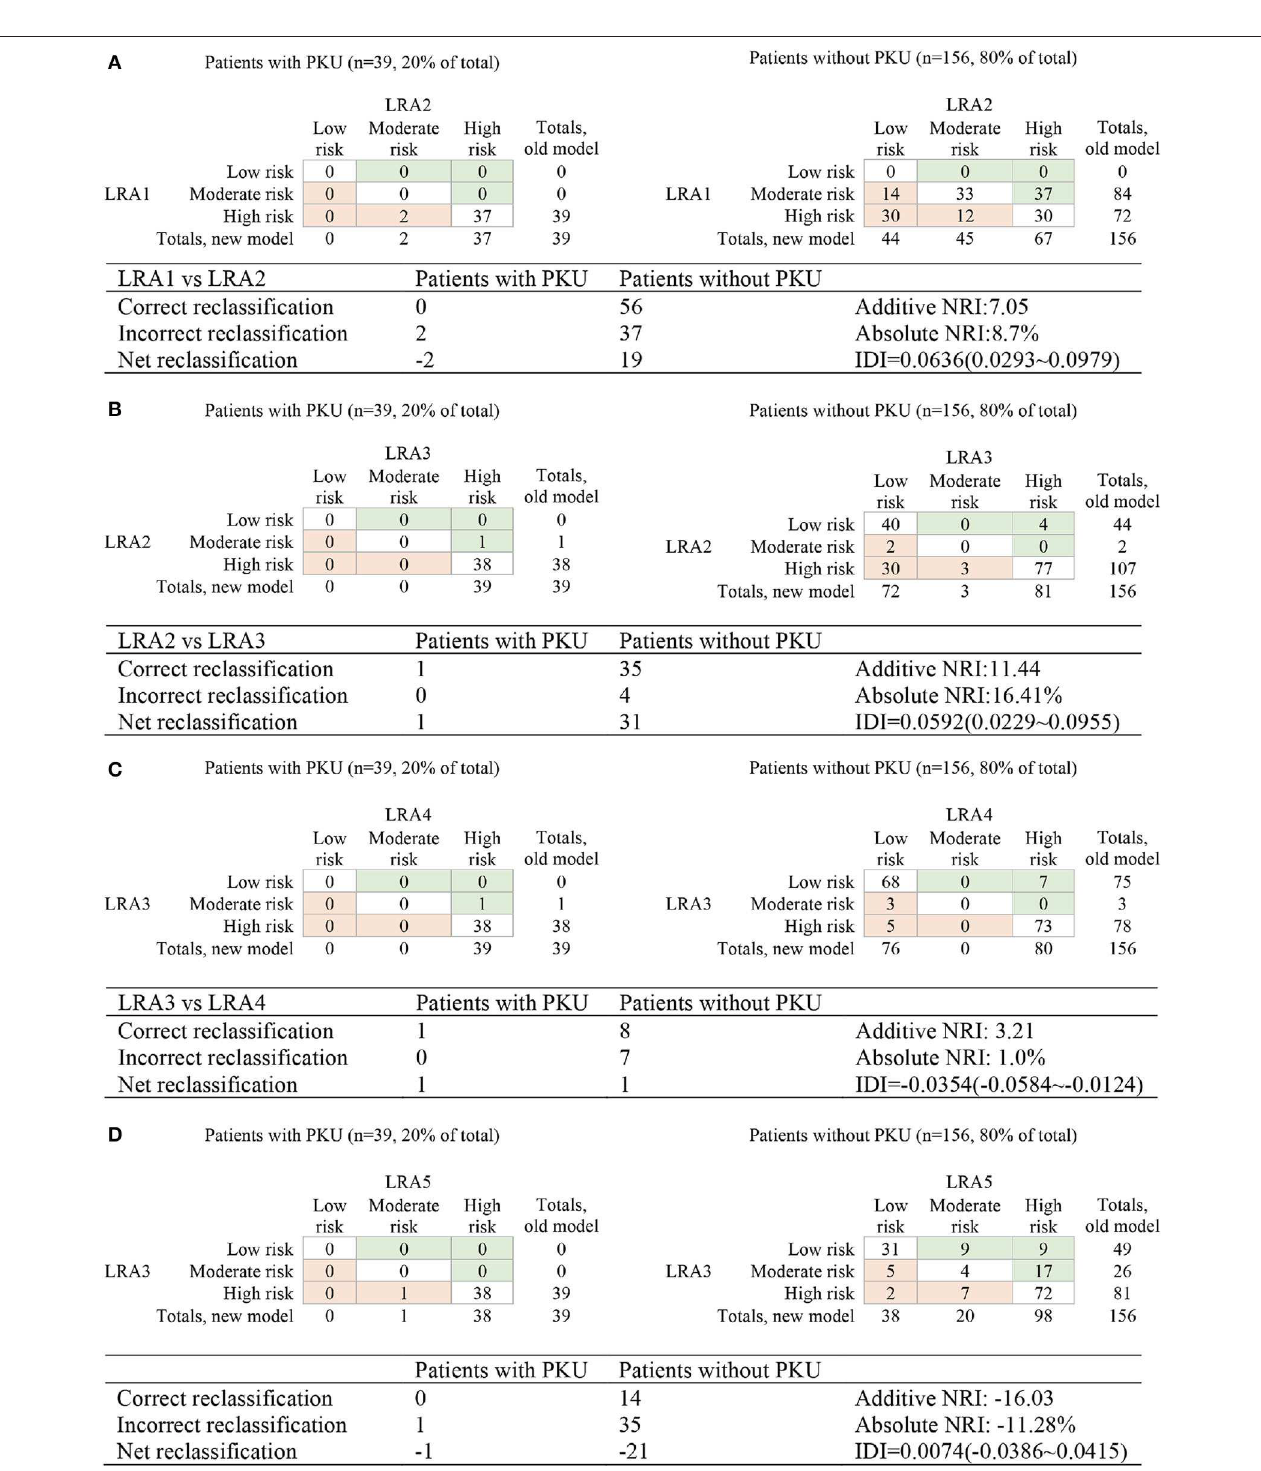
FIGURE 4 | Reclassification of risk for the comparison of the performance of LRA1–LRA5. (A) Compare LRA1 and LRA2; the low risk < 0.0528, medium risk 0.528–0.0948, and high-risk > 0.0948. (B) Compare LRA2 and LRA3; the low risk < 0.0528, intermediate risk 0.0528–0.0579, and high risk > 0.0579. (C) Compare LRA3 and LAR4; the low risk < 0.0220, medium risk 0.0220–0.0579, and high risk > 0.0579. (D) Compare LRA3 and LAR5; the low risk < 0.0220, medium risk 0.0220–0.0579, and high risk > 0.0579.